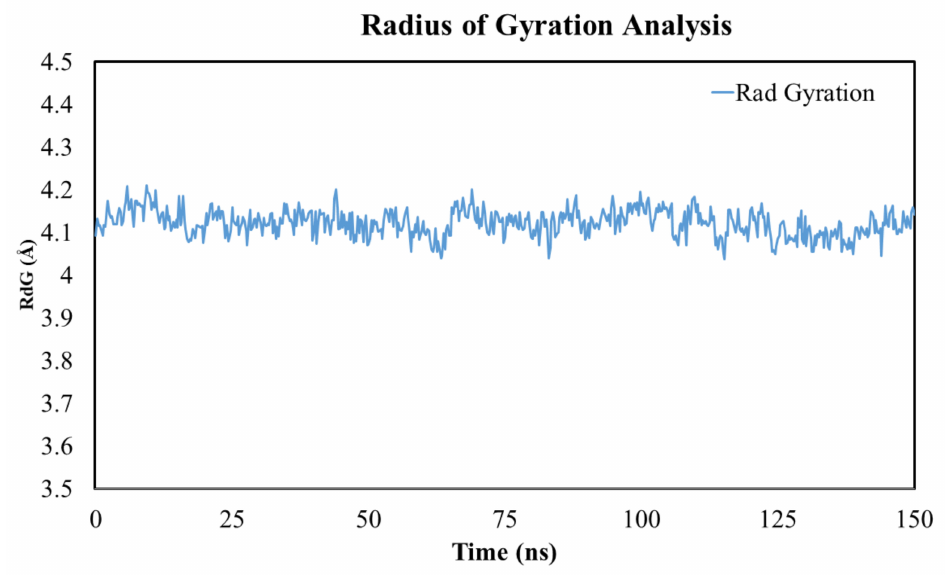
Figure 10. The MD simulation analysis using the radius of gyration (RdG) plot. The MD simulation analysis of the TLR-4 and rutin complex showed a radius of gyration within the acceptable